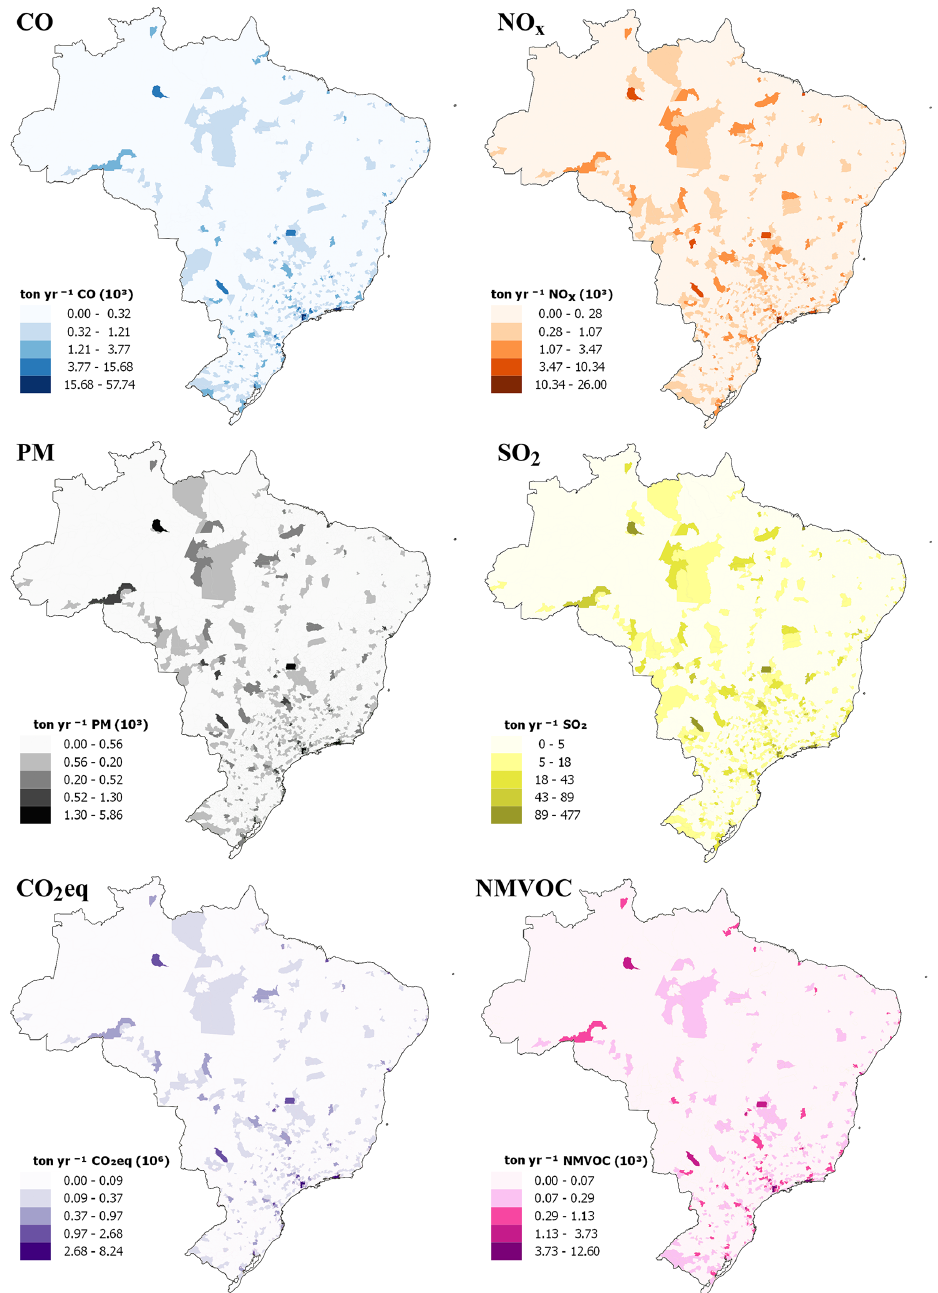
Figure 1. Vehicular emissions inventory in 2019 of (a) CO, (b) NO x , (c) PM, (d) SO 2 , (e) CO 2 , and (f) NMVOC provided by BRAVES (Vasques and Hoinaski,